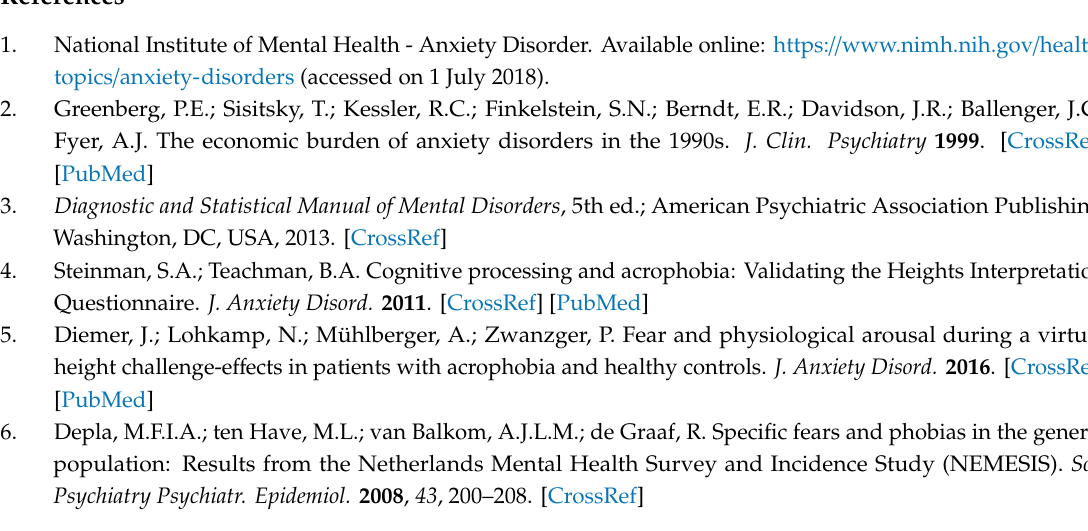
Figure A1. The we questioner participants answered after both VR-MC and VR-HC